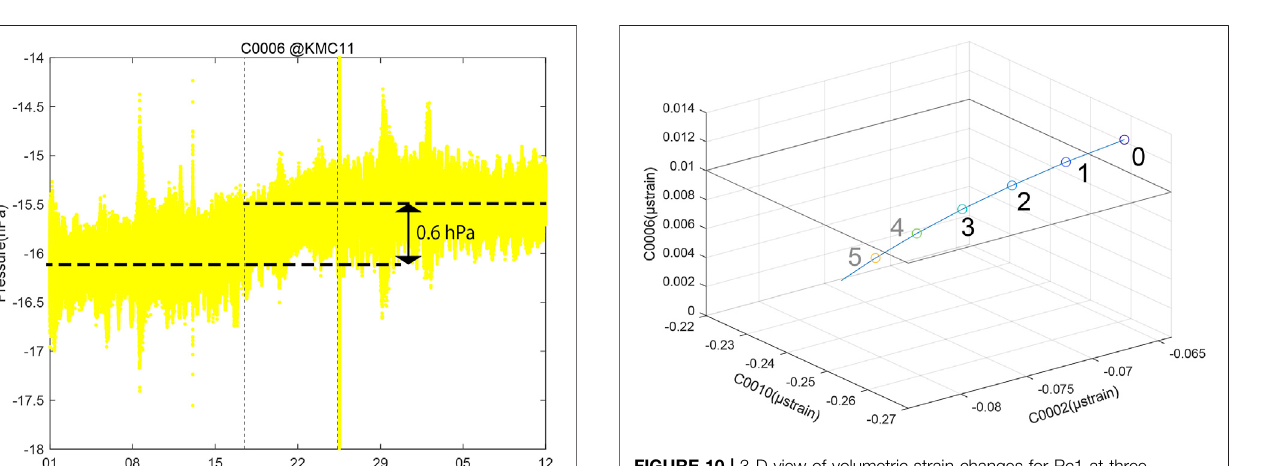
TABLE 2 | Volumetric Strain as a function of dip angle for the fault model A-2.